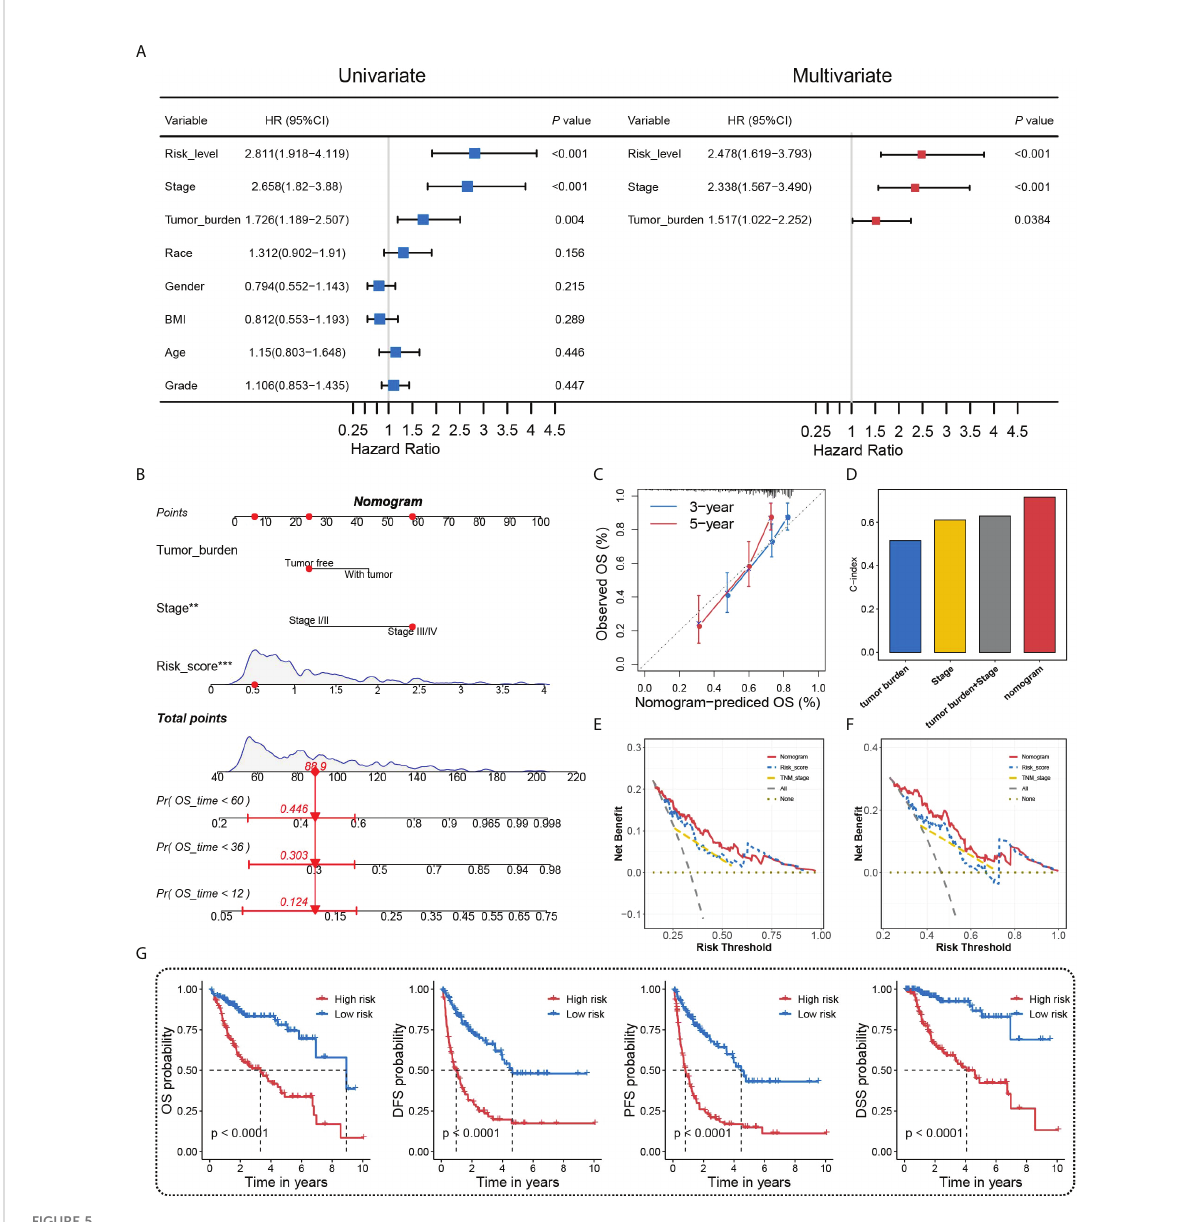
FIGURE 5 Nomogram construction and assessment. (A) Univariate and multivariate Cox regression analyses of HGSIS and other clinicopathological traits for OS in HCC patients. (B) Nomogram built by HGSIS, stage, and tumor burden to predict 1-,3- and 5-year OS in HCC patients. (C) Calibration plot of the nomogram. (D) C-index values of the nomogram and clinicopathological traits. (E, F) Comparison of net bene fi ts of each model for 3-year (E) and 5-year (F) OS. (G) Kaplan – Meier survival analysis of the integrated nomogram for OS, DFS, PFS, and DSS in HCC